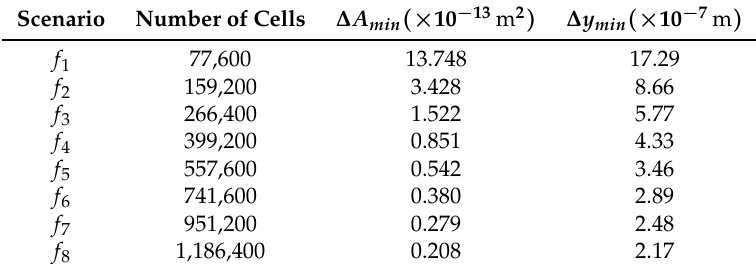
Table 2. Mesh refinement specifications for grid independence